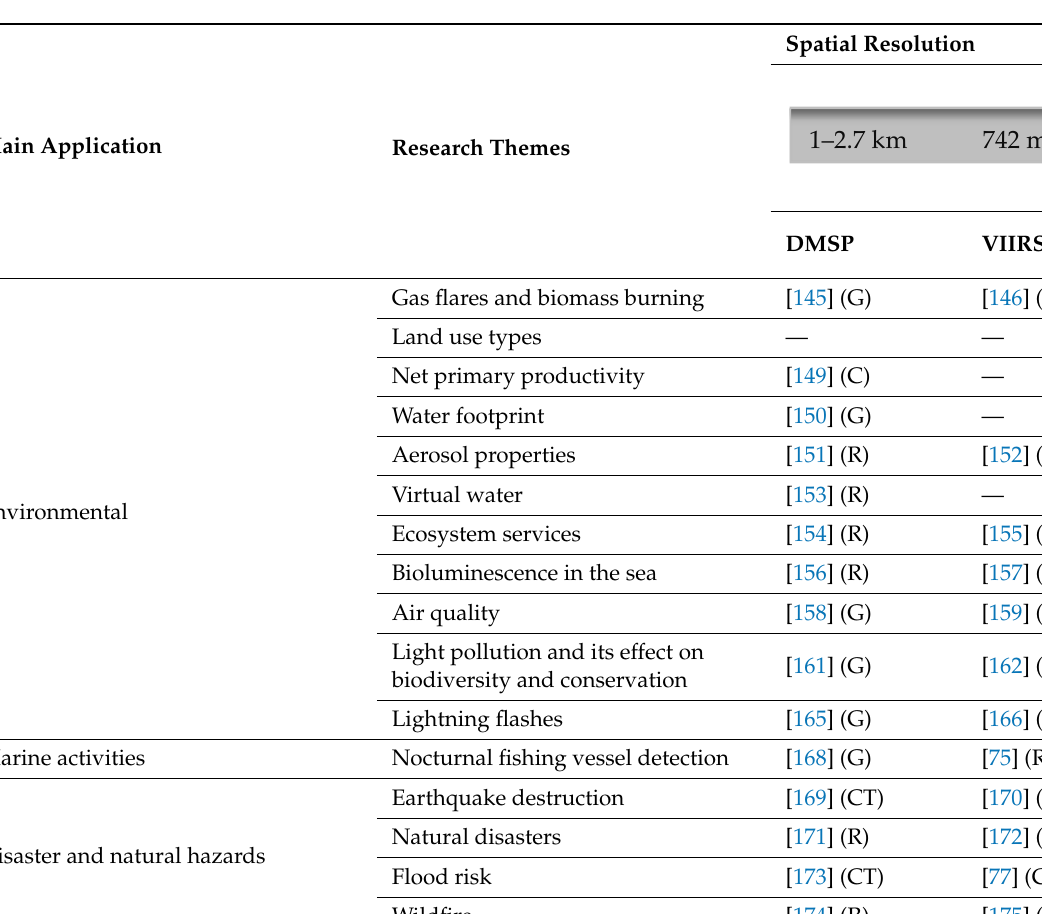
Table 3. Applications of night-time satellites by spatial resolution and location. G — Global; R — Regional, CT — Country; C — City; L — Table 3. Cont.